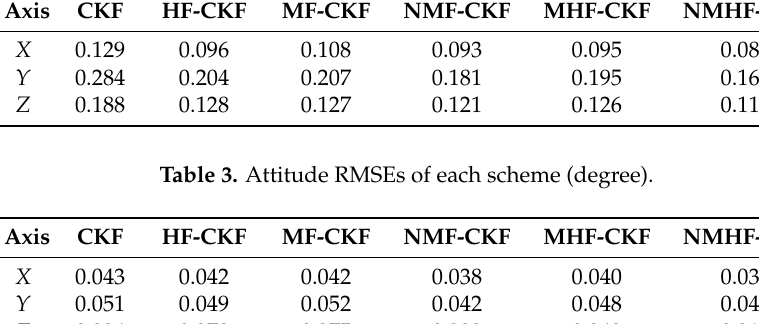
Table 2. Position RMSEs of each scheme (meter).